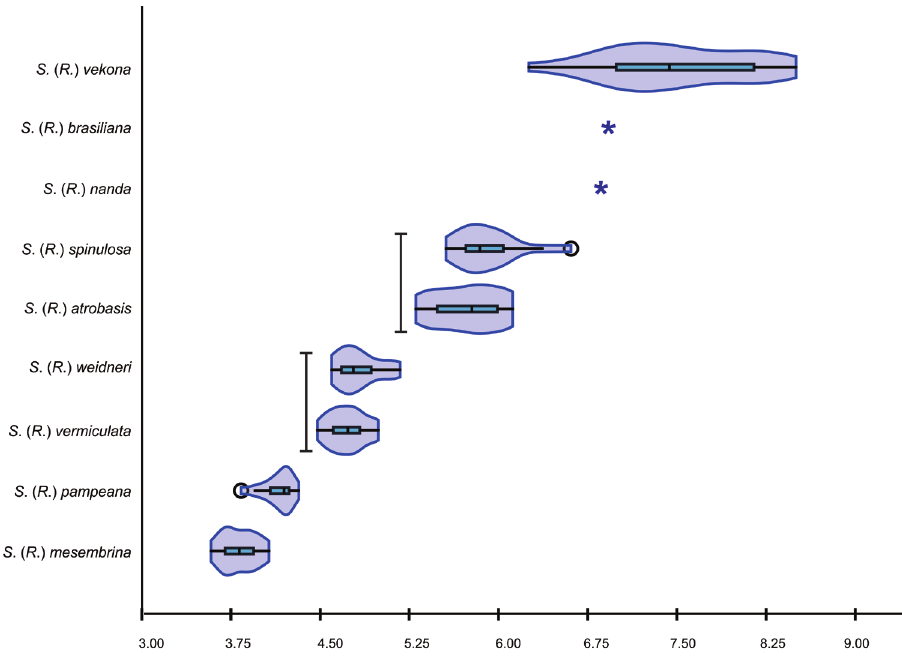
Figure 10. Violin plot of the centroid sizes (CS) of the wings of the ten Smicridea species analyzed. Bar: no significant differences between CSs (p > 0.05). *: n =